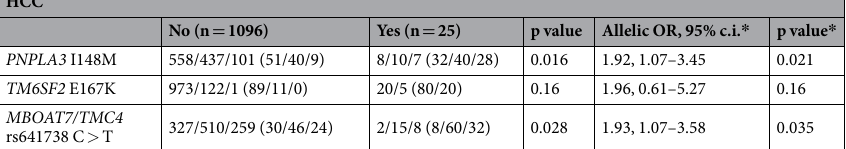
HCC No (n = 1096) Yes (n = 25) p value Allelic OR, 95% c.i. *